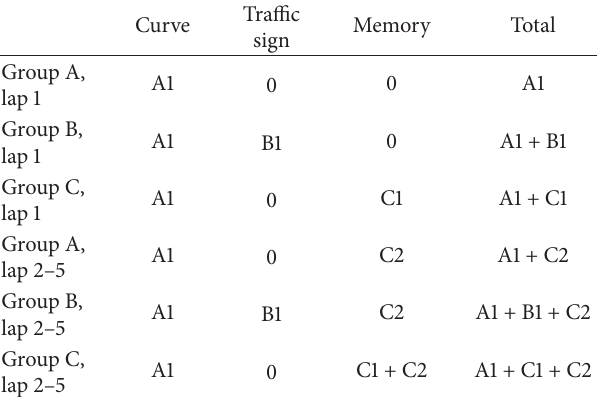
Table 2: The confidence value of different